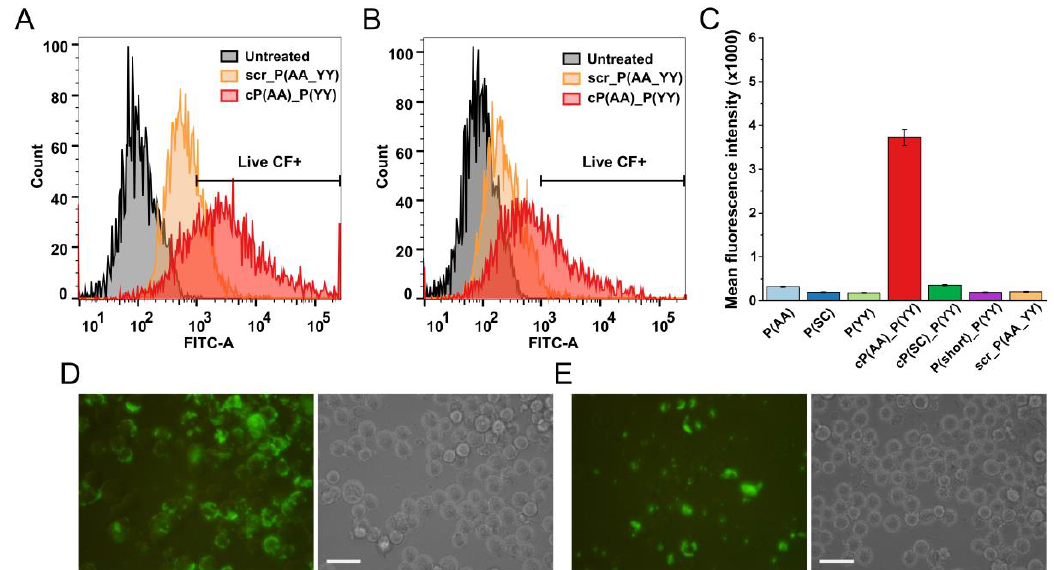
Figure 3. Effect of increased trypsinization time on cellular uptake of CF-labeled peptides by MDA-MB-453 cells. ( A , B ) Histogram of cellular uptake followed by 5 and 15 min of trypsinization, respectively. ( C ) Mean fluorescence intensity after 15 min of trypsinization. Cells were incubated with the conjugates (12.5 µM) for 3 h. Flow cytometry was measured by a BD LSR II flow cytometer. The mean and standard deviation of two parallels are depicted. The experiments were repeated twice. ( D,E ) Cellular uptake captured by fluorescence microscopy after 5 and 15 min of trypsinization, respectively. Scale bars represent 50 µm.